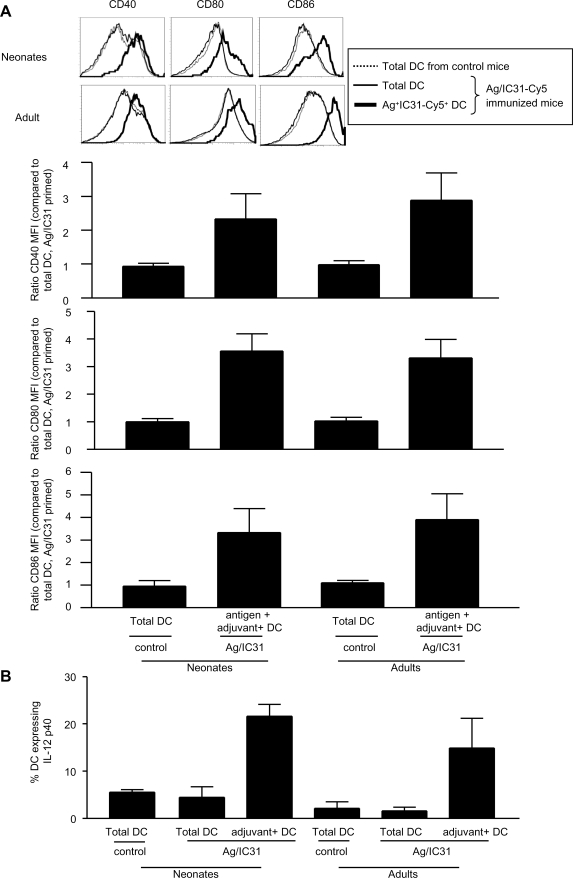
Targeted functional activation of DC in neonates and adults.Twenty-four hours after immunization, (A) the expression of CD40, CD80 and CD86 and (B) IL-12p40 by total DC and adjuvant+ DC was assessed. Histograms represent the expression of co-stimulation molecules by total DC in control mice (dotted line), total DC (thin lined histogram) and Ag85B-ESAT-6+ IC31®+ DC (thick lined histogram) in Ag85B-ESAT-6/IC31®-immunized mice. Data is expressed as mean and SD of groups of at least 5 individual mice, and is representative of 2–3 independent experiments.